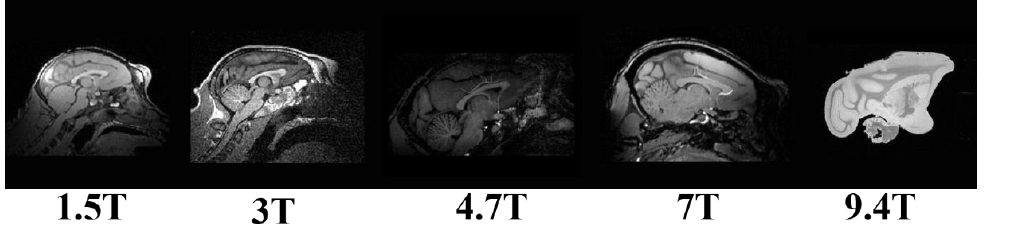
Figure 2. Schematic diagram of signal difference of macaque brain on 1.5 T, 3 T, 4.7 T, 7 T, and 9.4 T.